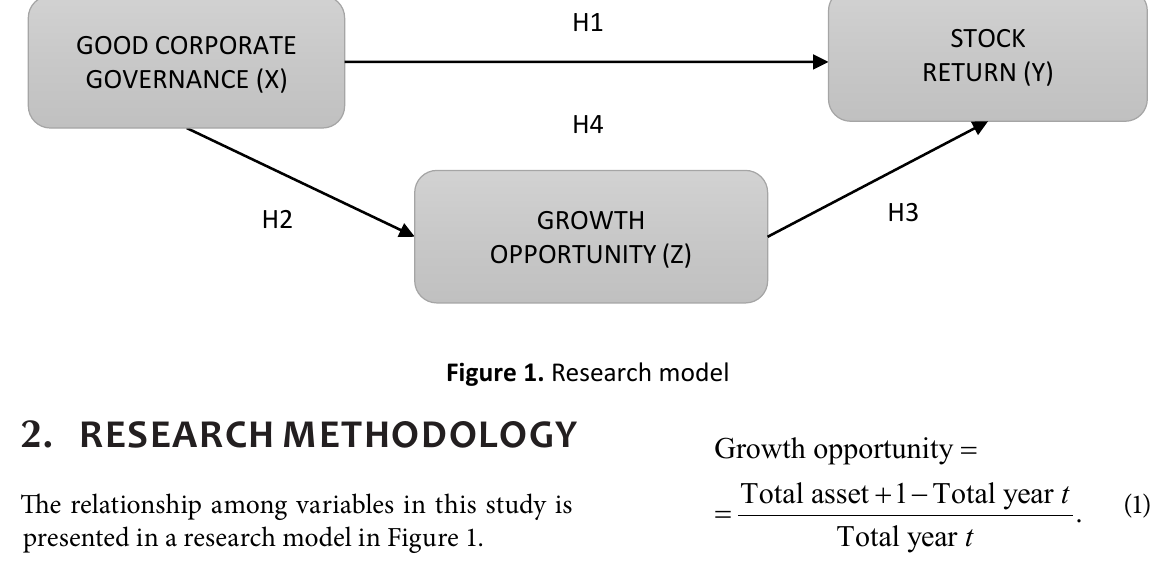
Figure 1. Research